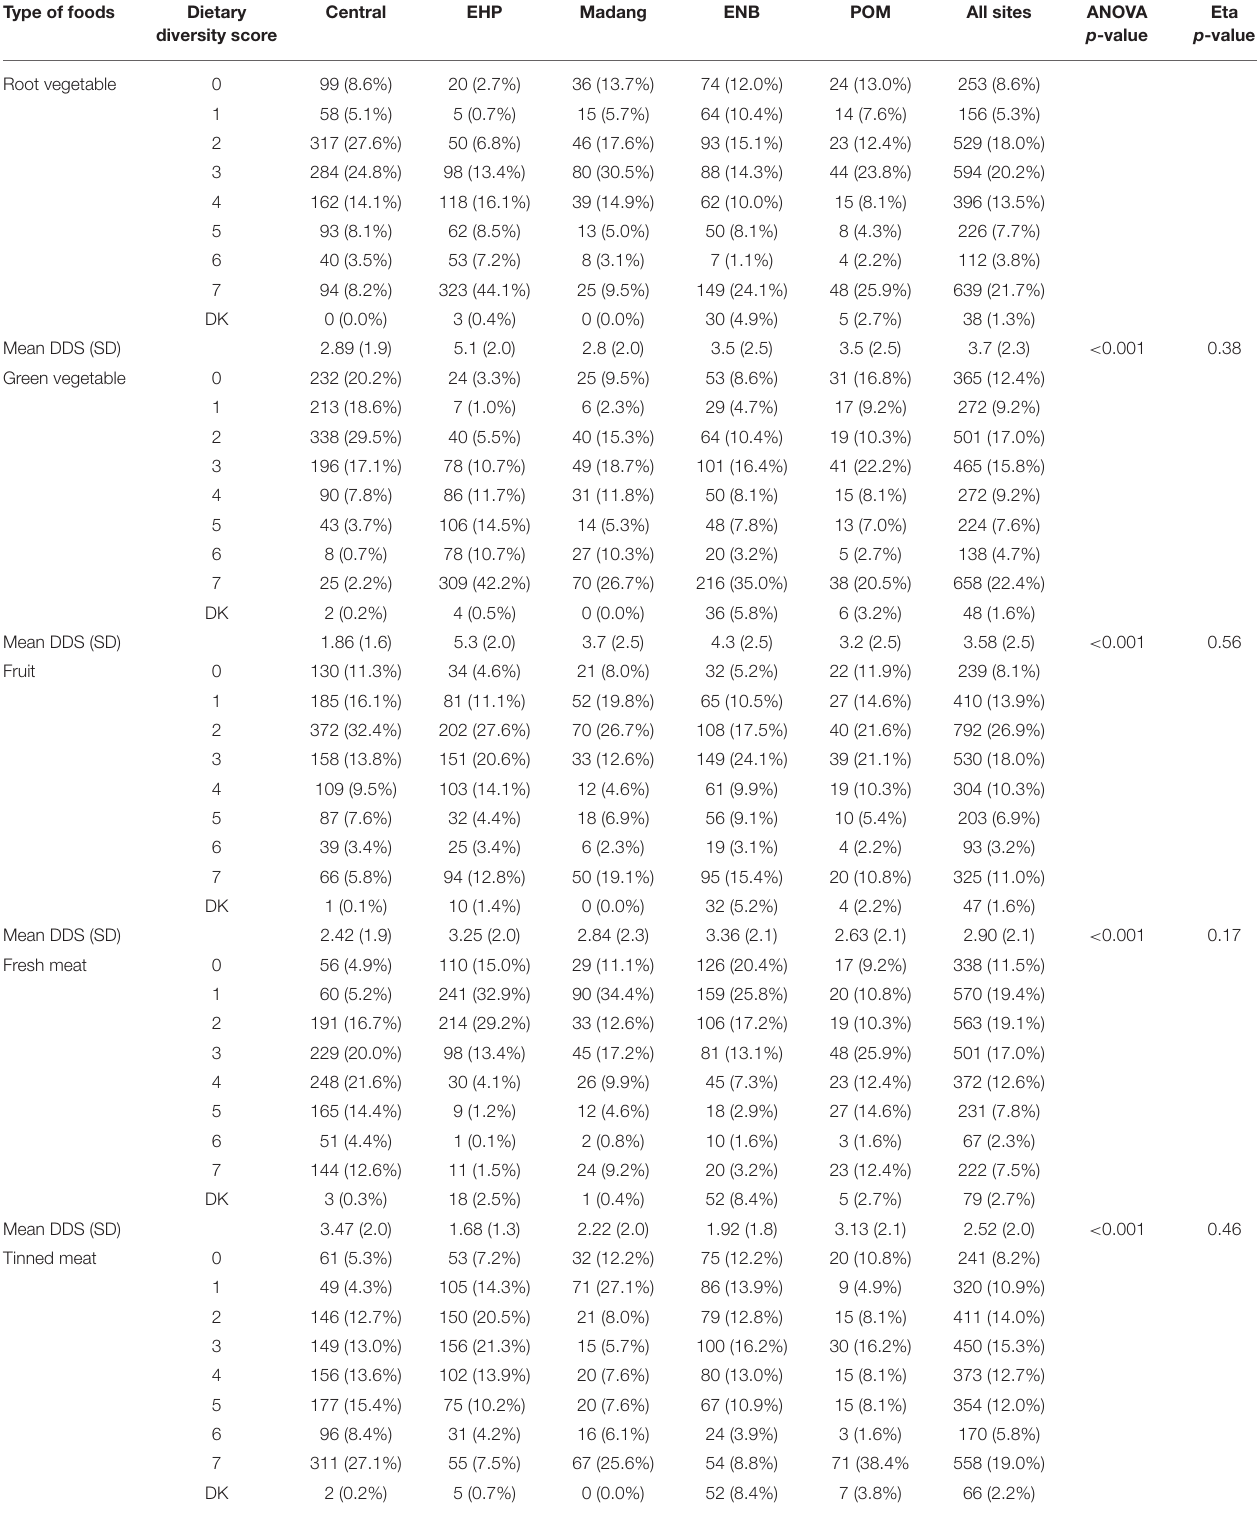
TABLE 4 | Dietary intake and dietary diversity score among children aged 6–59 months for a typical week by surveillance site, PNGIMR’s CHESS,